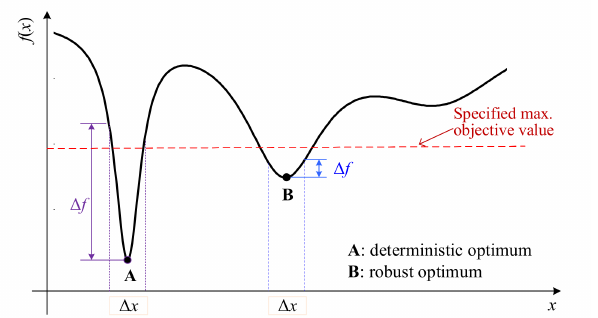
Figure 3. A comparison between the deterministic optimum and robust optimum in the presence of uncertainties for a function f ( x ), in which ∆ x and ∆ f stand for the variations of the parameter and objective,